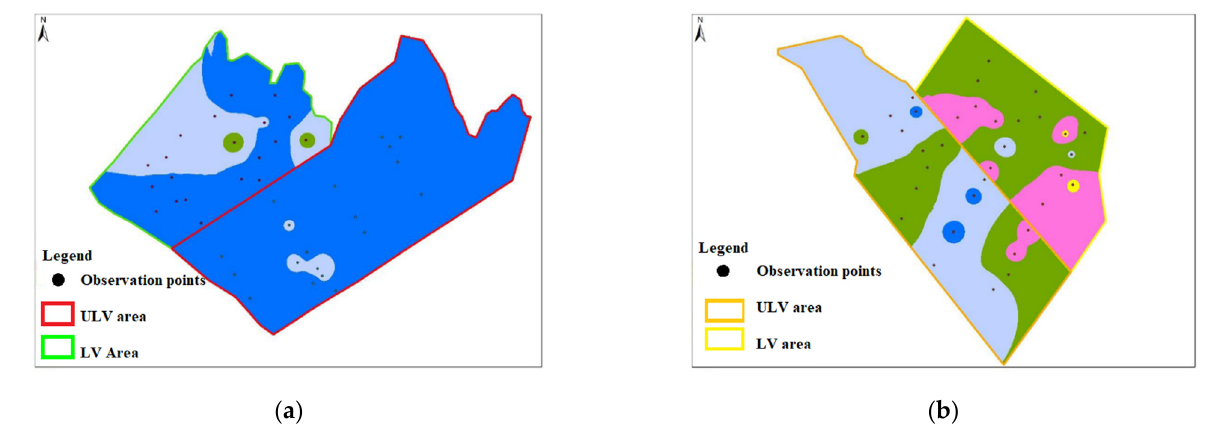
Figure 9. Thematic maps showing attack intensity by insecticide type and treatment volume: ( a ) contact insecticide (Forest A); and ( b ) systemic insecticide (Forest B). very weak discoloration (0–10%); weak discoloration (11%–25%); medium discoloration (26%–50%); strong discoloration (51%–75%); and very strong discoloration (76%–100%).